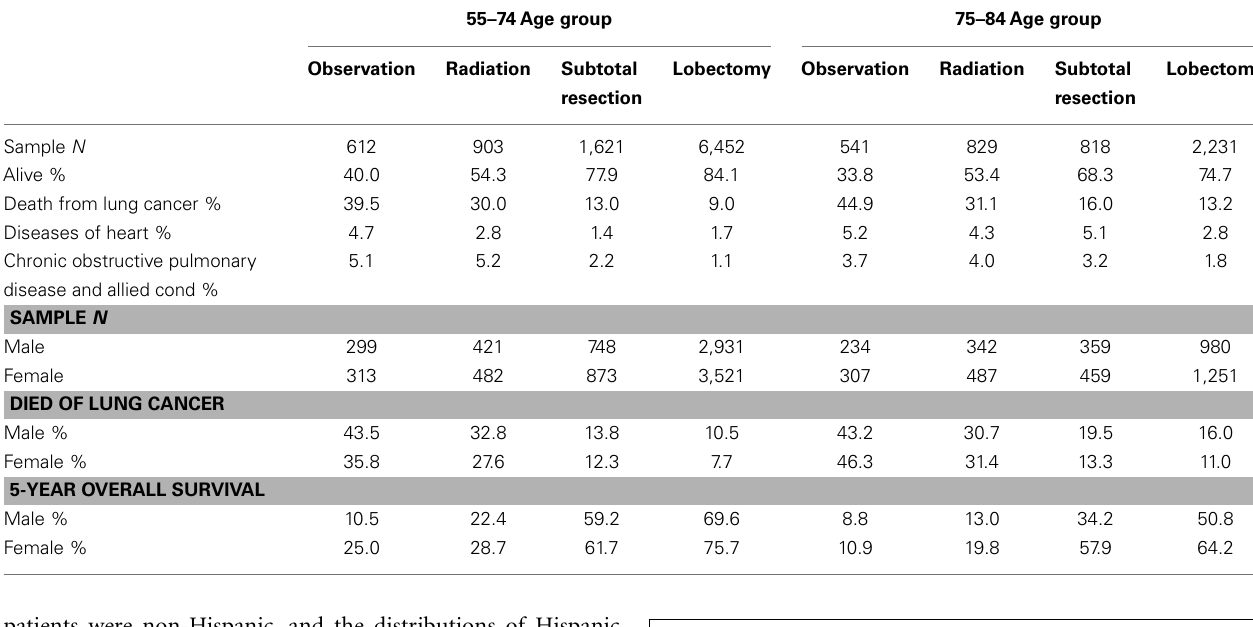
Table 2 |Top three causes of death and 5-year overall survival rates in patients with stage I non-small cell lung cancer, 2004–2009 .